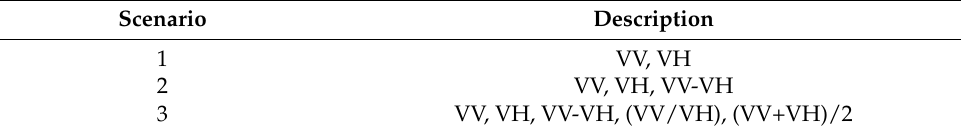
Table 2. Scenario for VH and VV bands’ combination.